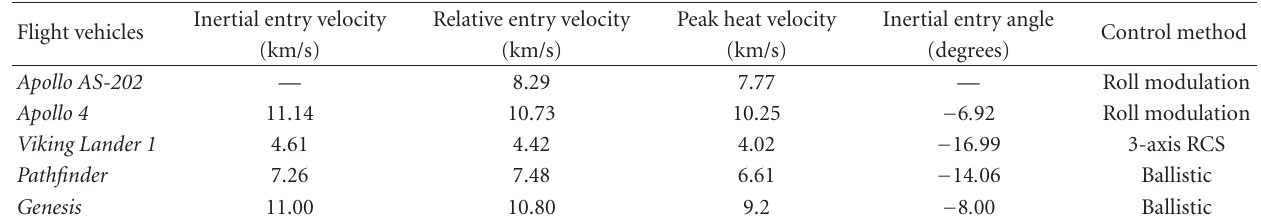
Figure 21: Probe database configurations and geometry constructions. Table 9: Database of entry vehicles and flight entry trajectory